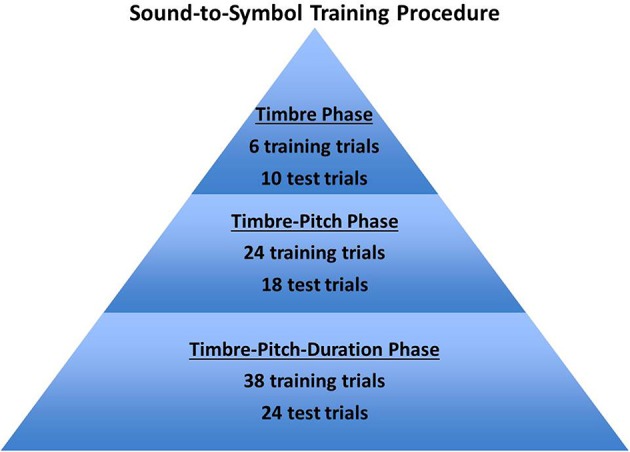
Summary of the sound-to-symbol training procedure to familiarize participants with the sound-to-symbol mappings, involving timbre, pitch, and duration dimensions.